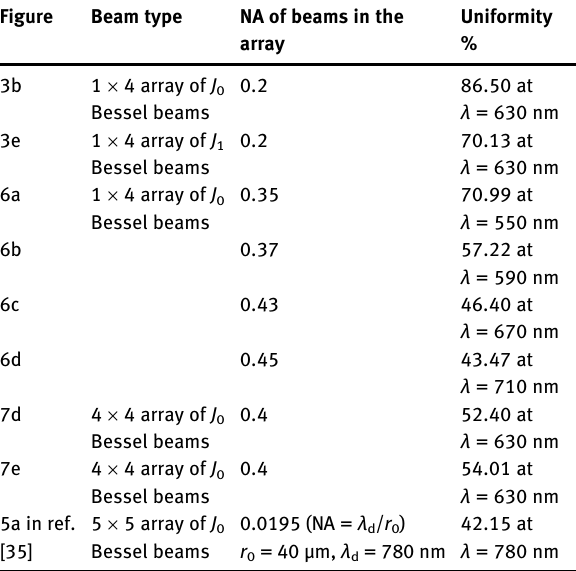
Table  : Summary of the uniformity values of the arrays with different beam parameters.